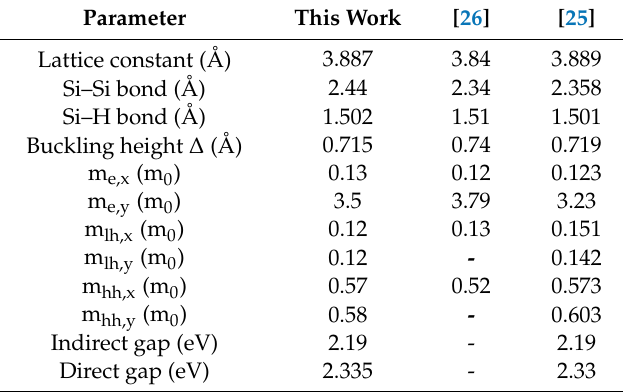
Table 1. Silicane